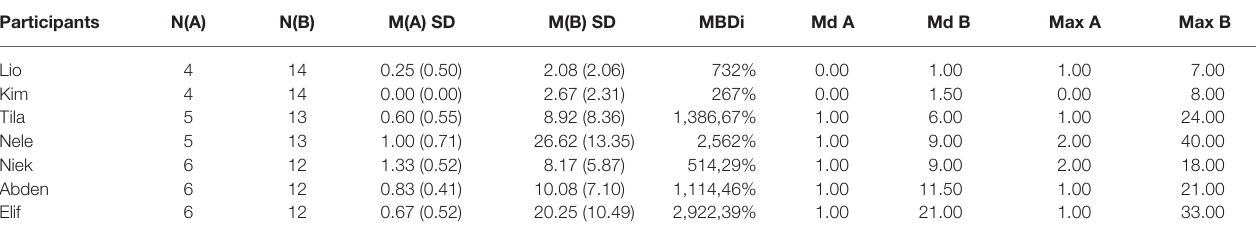
TABLE 8 | Descriptive data for words read correctly. Participants